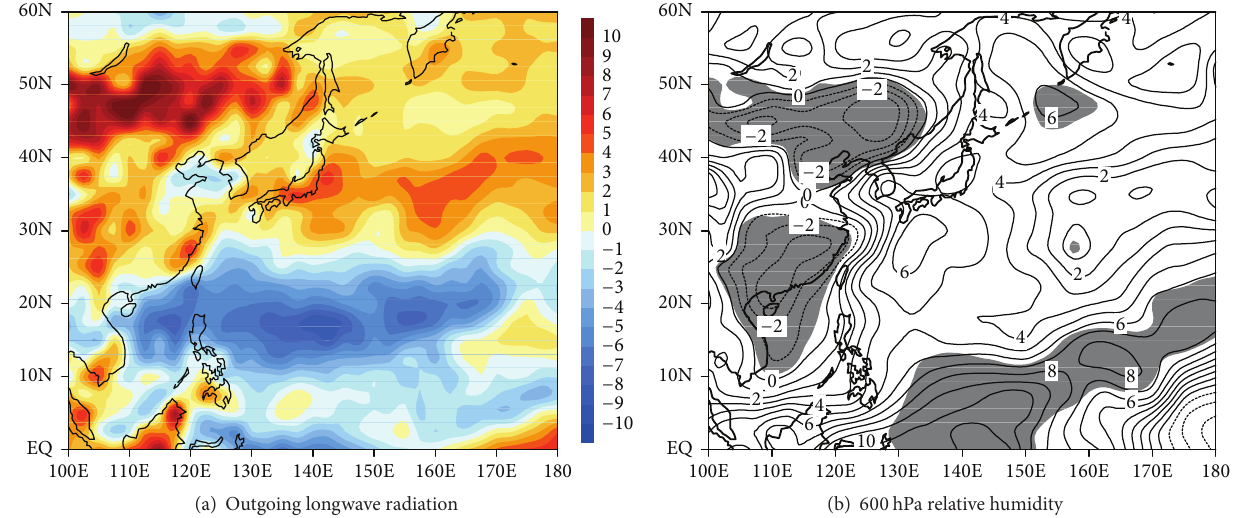
Figure 4: Same as in Figure 3, bur for (a) outgoing longwave radiation (OLR) and (b) 600 hPa relative humidity. In (b), contour interval is 1% and shaded areas are significant at the 95% confidence